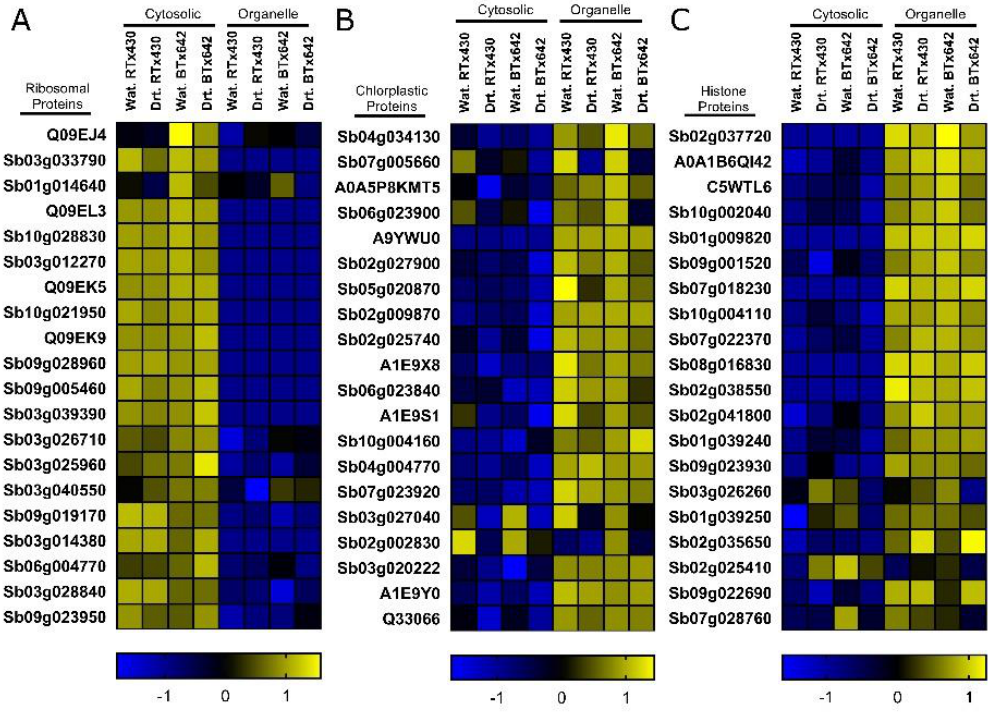
Figure 1. Evaluation of cytosolic and organelle enrichment. Ribosomal proteins abundant in the cytoplasm were more abundant in cytosolic-enriched samples ( A ), while photosynthesis-related chloroplastic ( B ) and nuclear histone proteins ( C ) were more abundant in organelle-enriched samples. Color and scale bars represent average Z -score transformed protein abundances of all biological replicates for each sample. Protein identifiers correspond to STRING or UniProt accessions. Wat., Watered; Drt.,